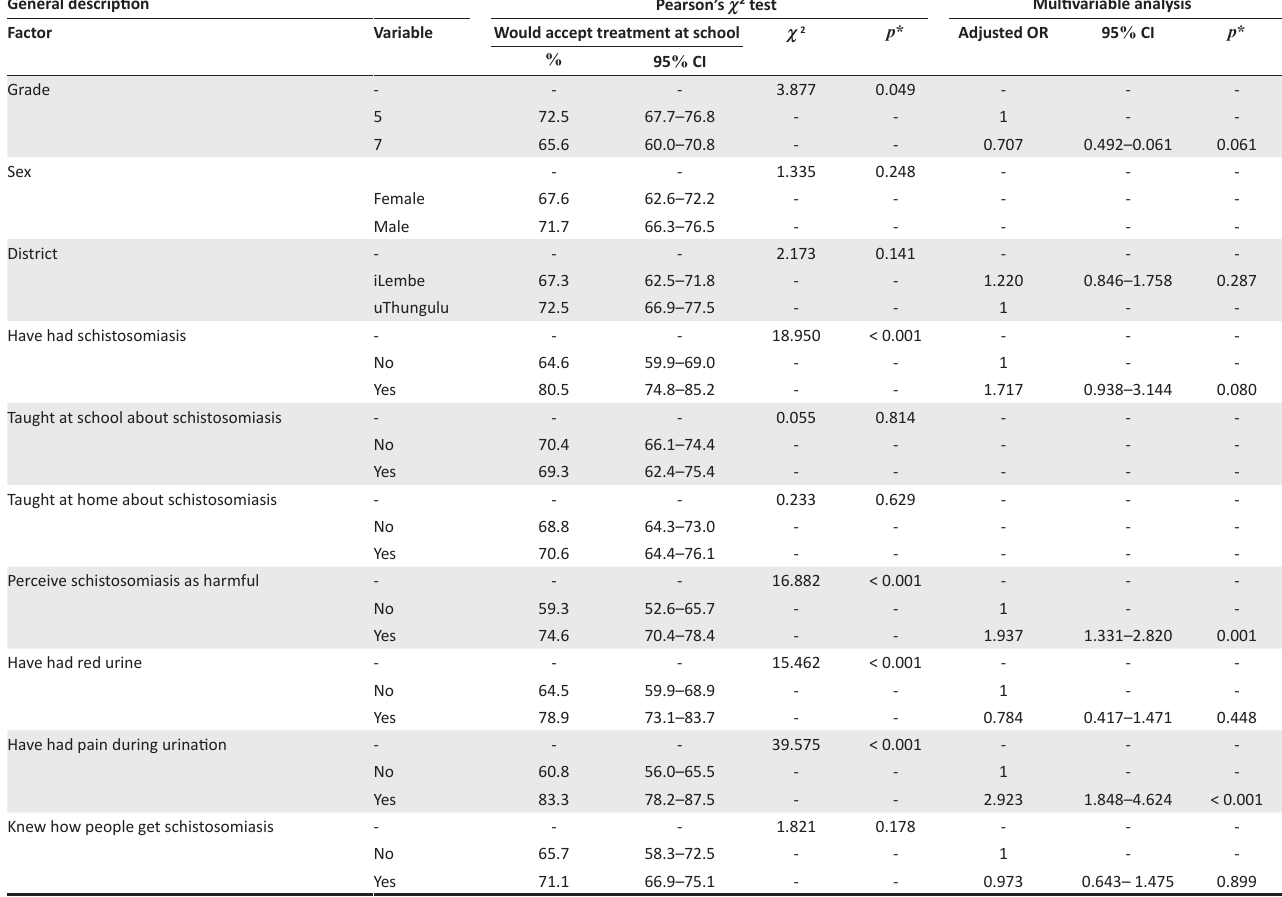
TABLE 4: Pearson’s χ 2 test of factors affecting the willingness of learners and teachers to receive treatment at school. General